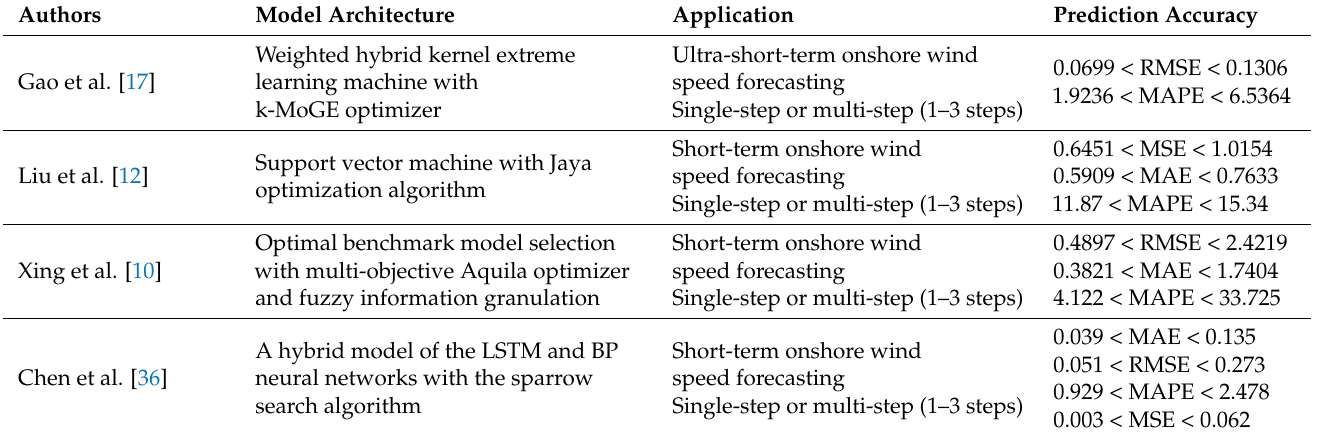
Table 1. Model architectures, applications, and prediction accuracies of wind speed and wind power forecasting